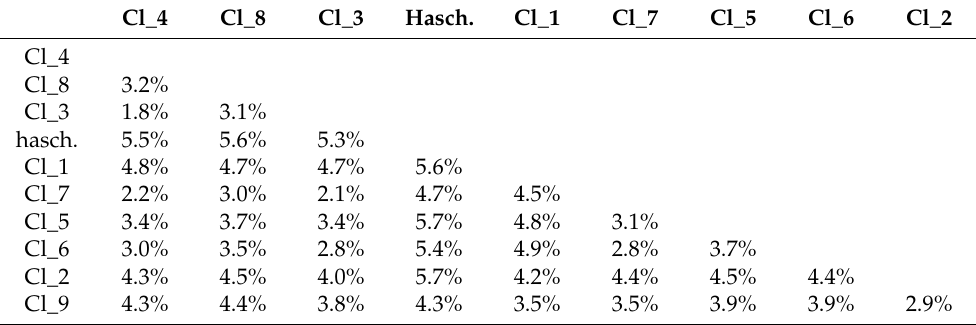
Table 4. Mean genetic distances (in %) of Clades 1–12 (see Figure 1) of frogs referred to as Limnonectes limborgi as well as L. hascheanus based on the 16S dataset. Cl = Clade; hasch. = hascheanus. See text for